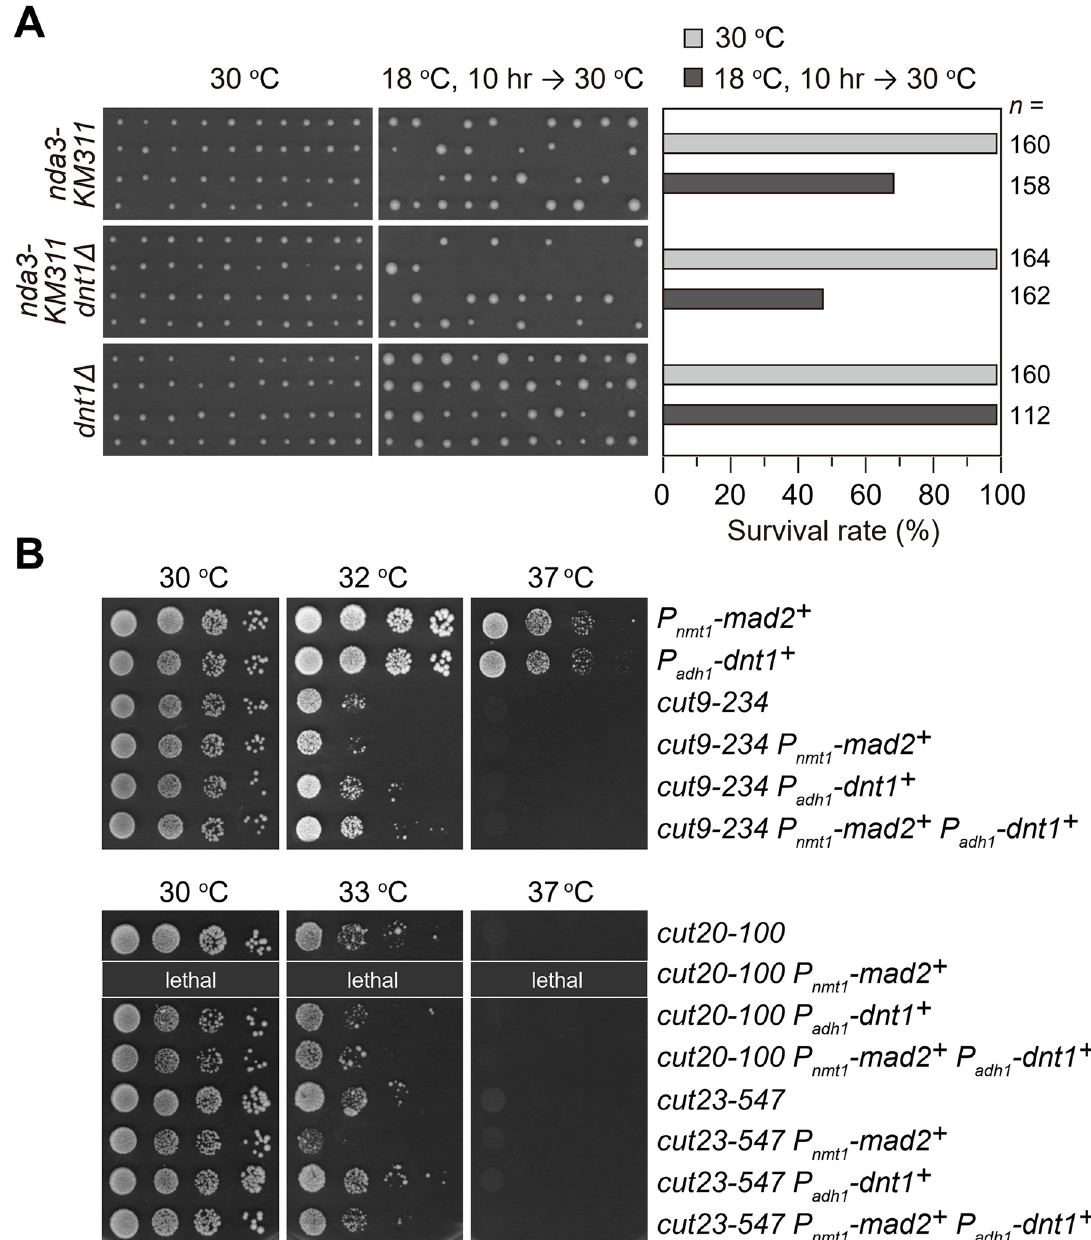
Fig 6. Dnt1 involves in antagonizing SAC and maintaining cell survival upon spindle checkpoint activation. ( A ) nda3-KM311 dnt1 Δ cells lose viability after transient cold-shock. nda3-KM311 dnt1 + , nda3-KM311 dnt1 Δ or dnt1 Δ cells were first grown at 30˚C in liquid cultures and then being shifted to 18˚C for 10 hours. Individual cells ( n � 80 for each strain) were isolated using tetrad dissection manipulator and placed on solid rich media at the permissive temperature of 30˚C ( Left ). The number of colonies formed before and after cold-treatment was quantified ( Right ). ( B ) Overexpressed Dnt1 antagonizes negative effect of Mad2 overexpression on loss-of- function APC/C mutants. Serial dilutions (10-fold) of the indicated strains were spotted on YE plates and incubated at the indicated temperatures. Overexpression of Mad2 and Dnt1 was achieved under nmt1 promoter ( P Note that cut20-100 P nmt1 -mad2 + mutant was lethal and thus not included in the spot assay.